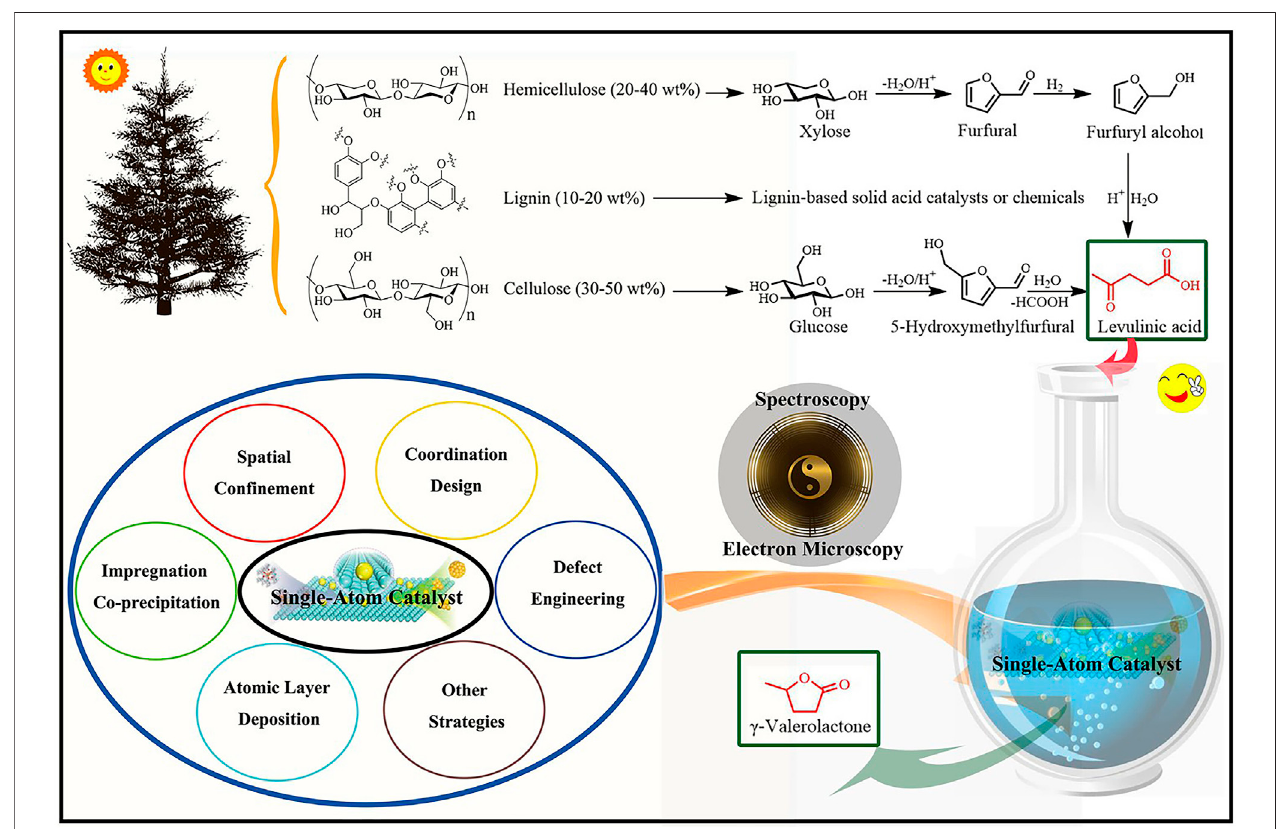
FIGURE 1 | The schematic of reductive upgrading of biomass-based LA (levulinic acid) to GVL ( γ -valerolactone) over single-atom catalysts.